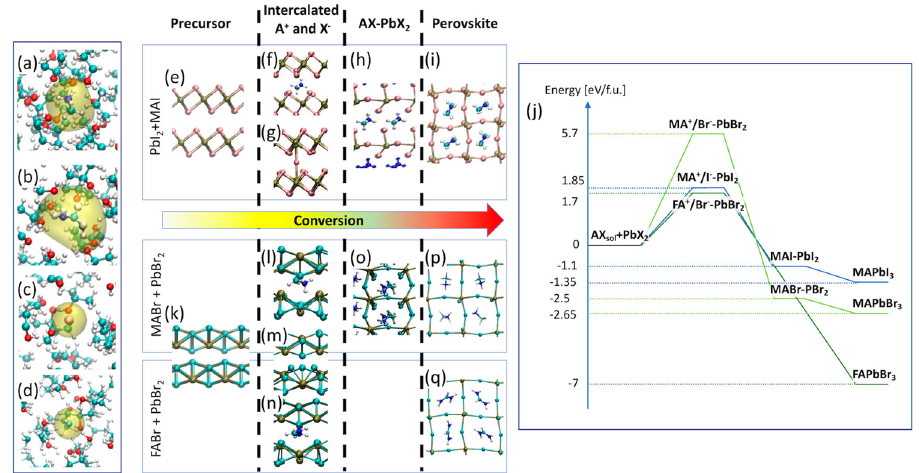
Fig. 4 Classical molecular dynamics and density functional theory calculations. a – d Selected con fi gurations of ions in isopropyl solution a MA + , b FA + , c I - and d Br - . The yellow shadow is added to help identify the ions in the solution. Initial, intermediate, and fi nal structures along with the CRs bringing to e – i MAPbI 3 , k and l – p MAPbBr 3 and k and n – q FAPbBr 3 . The fi rst block of panels e – i and k – q shows the lateral view of the precursor PbI 2 and PbBr 2 structures, putting in evidence the (quasi)-layered structure where intercalation of A + and X - takes place. The second block shows A + and X - ions intercalated in the precursor. The third block highlights the MAI-PbI 2 and MABr-PbBr 2 intermediate phases. Finally, the fourth block shows the fi nal products, the perovskite structures. j Energy diagram of the stable and metastable phases formed along the conversion reaction PbX 2 + A + sol + X - sol → APbX 3 (see also Supplementary Table 2). The energy of reactants, AX sol + PbX 2 , in particular the energy of solvated A + and X - ions, is obtained from DFT calculations of con fi gurations extracted from extensive Classical MD simulations (see the